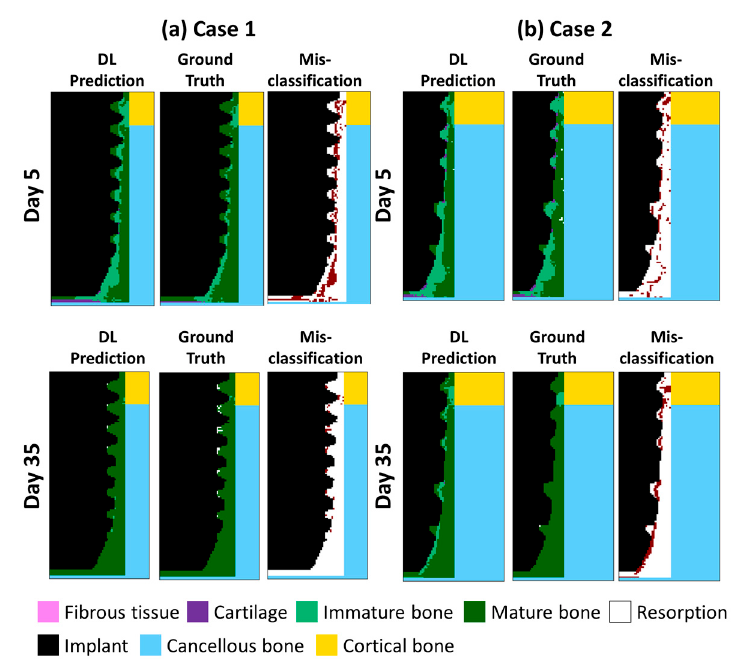
Figure 8. Tissue differentiation results on Day 5 and 35 for ( a ) Case 1 and ( b ) Case 2 with various boundary conditions.